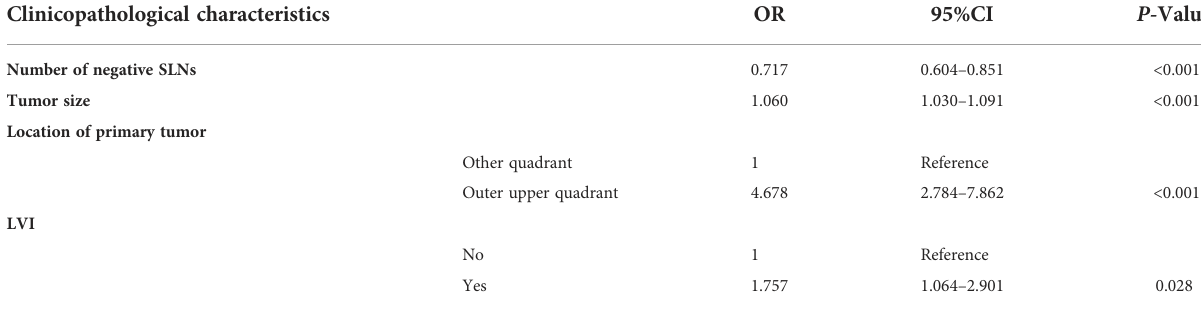
TABLE 3 Multivariate logistic regression analysis of NSLN metastasis based on clinicopathological data in the training cohort.